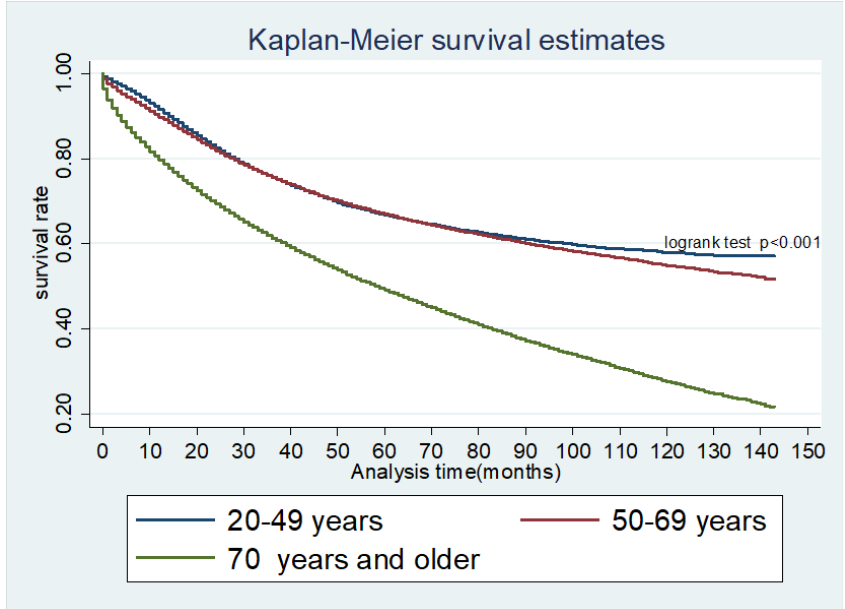
Figure 4. Kaplan Meier Survivor function: OS (overall survival) for age groups.